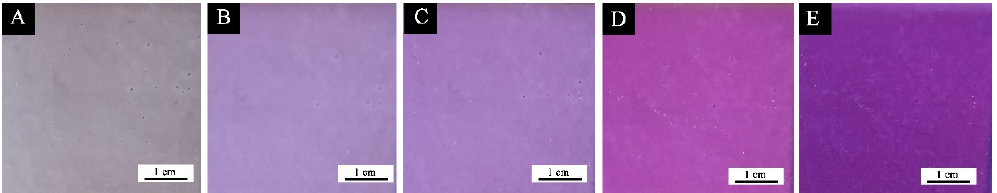
Figure 7. Color difference of the coatings.